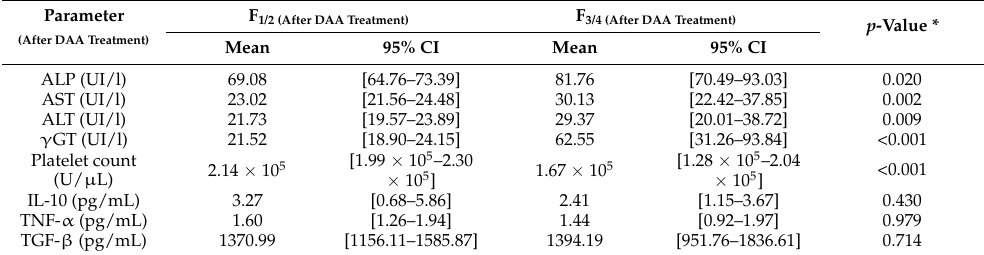
Table 3. Association of biochemical and cellular parameters after DAA treatment (continuous variables) with fibrosis stage after DAA treatment.